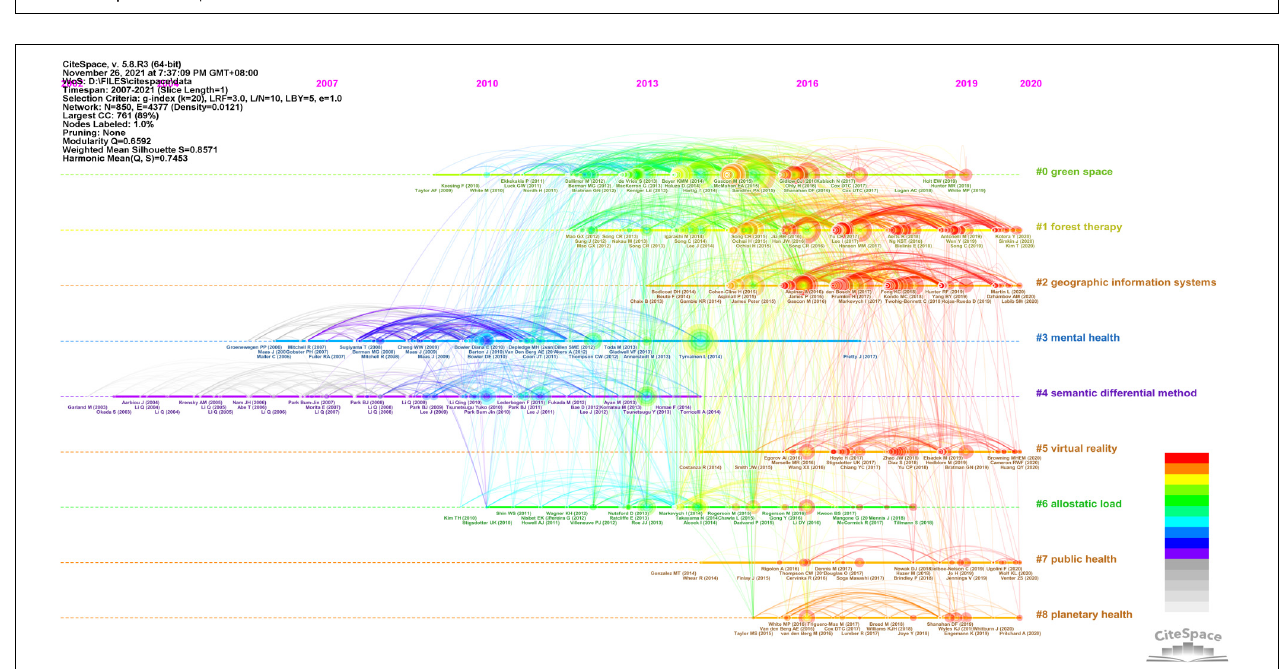
FIGURE 7 | A timeline visualization of the main clusters.